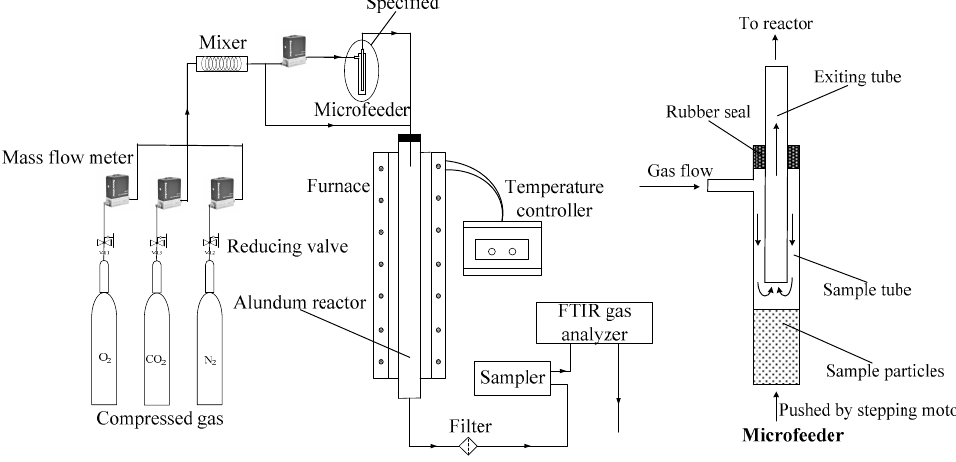
Figure 3. The schematic diagram of the experimental system for NO x emission during air and oxy-fuel combustion.